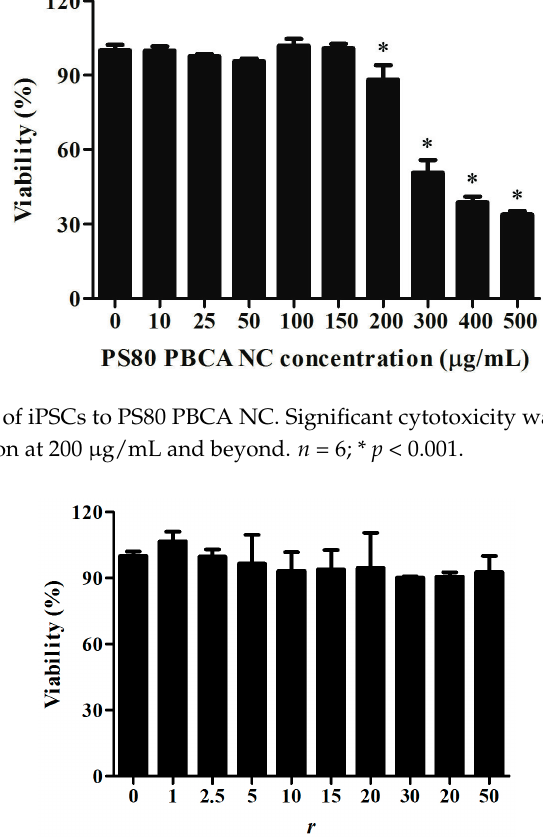
Figure 7. Cytotoxicity of iPSCs to PS80 PBCA NC/HRE-cmvBDNF at different weight ratios. No significant cytotoxicity was observed with a ratio of up to 50:1. r is the weight ratio of the PS80 PBCA NC to 2 μ g/mL of HRE-cmvBDNF. n = 6; p > 0.05.